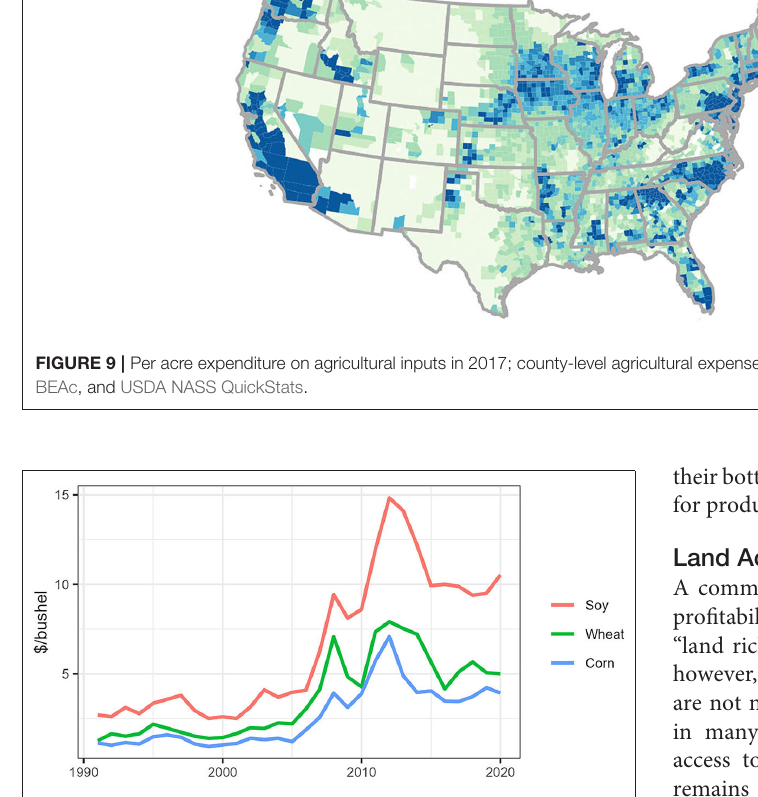
FIGURE 10 | Major commodity prices, adjusted using the price as paid index (PPITW) provided by the National Agriculture Statistics Service based on instruction for deflation from Jeff Gillespie, REE-ERS. Data: ( USDA ERS, 2021c